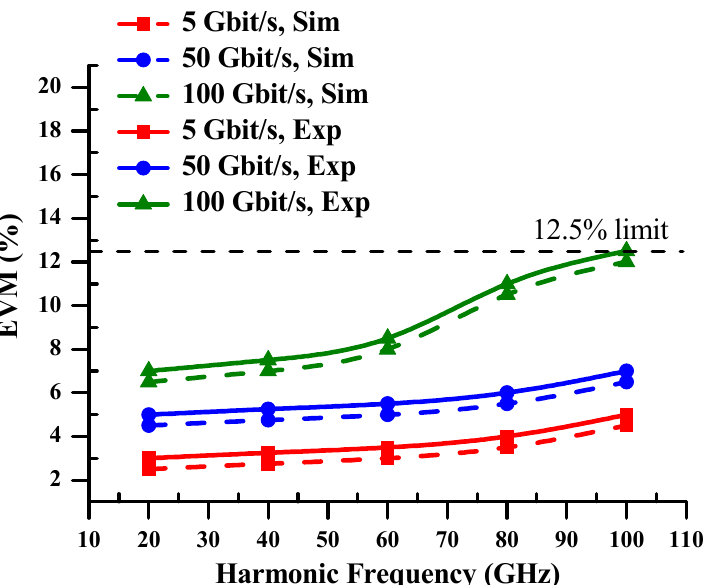
Figure 10. The experimental and simulated EVMs at the SOA-MZI output for the 16-QAM “AND” signal at several bit rates and common harmonics frequencies.